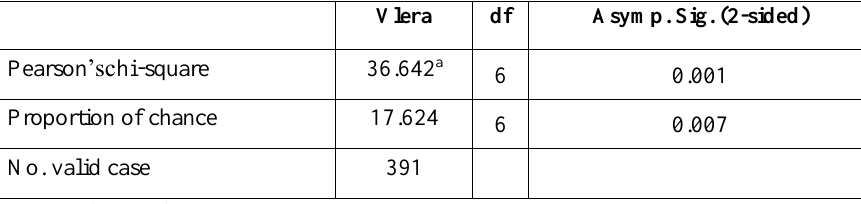
Table 5. Chi-Square Test (developed by the author)